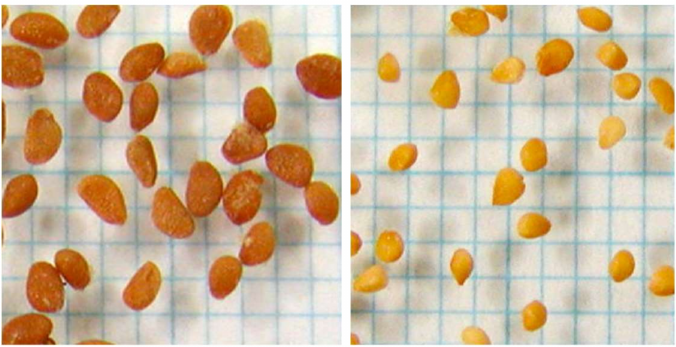
Figure 3. Difference in seed coat color between brownish ( left ) and whitish ( right )